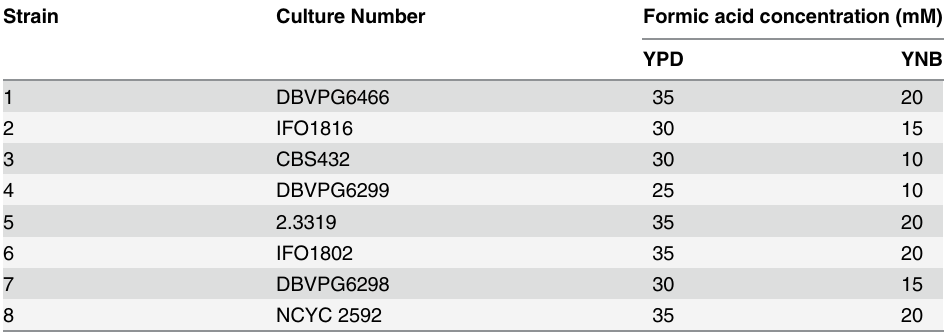
Table 2. Summary of formic acid tolerance concentrations of Saccharomyces spp by spot plate analysis. Strain Culture